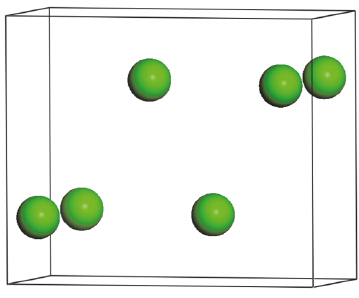
Figure 1: Alpha uranium unit cell.